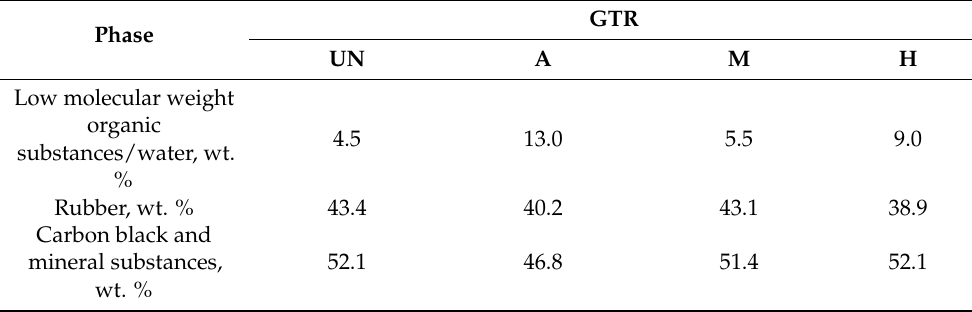
Table 3. GTRs phase composition determined by thermogravimetric